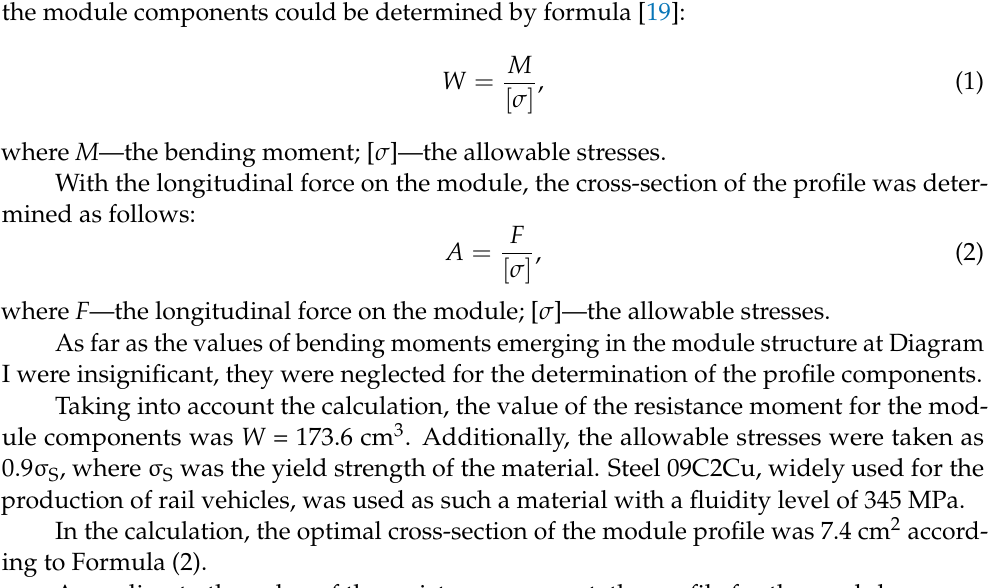
Figure 6. Diagram of the longitudinal forces (kN).